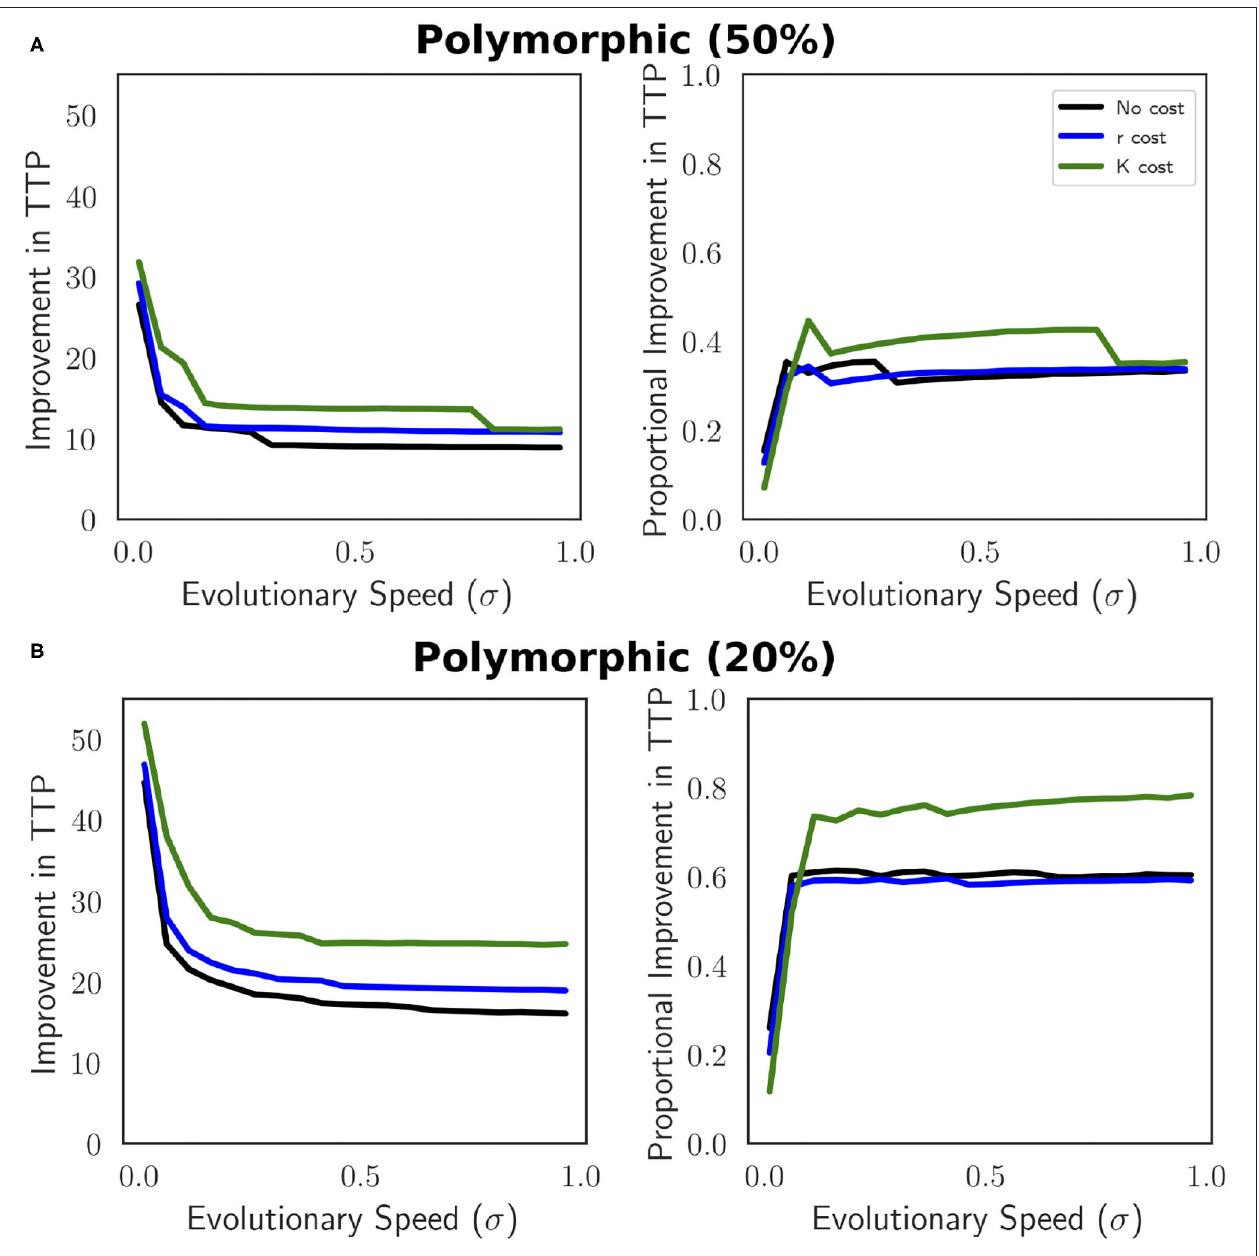
FIGURE 5 | Improvement in TTP ( TTP AT − TTP MTD ) and proportional improvement in TTP (( TTP AT − TTP MTD ) / TTP MTD ) as a function of evolutionary speed for a polymorphic tumor cell population. (A) Therapy is withdrawn once the population density ≤ 3,000 (50% of the initial population size) and re-administered once the population ≥ 6,000 (initial population size). (B) The threshold to remove therapy is reduced from 50% to 20%. Therapy is withdrawn once the population density ≤ 4,800 (20% decrease from initial population size) and re-administered once the population ≥ 6,000 (initial population size). The benefit of AT increases at faster speeds of evolution. A reduction in the magnitude the tumor population decreases before therapy can be withdrawn makes AT more effective. The parameters used in this figure are: m = 1, K max = 10,000, r max = 0.45, k = 2, b = 10, d = 0.01, g =